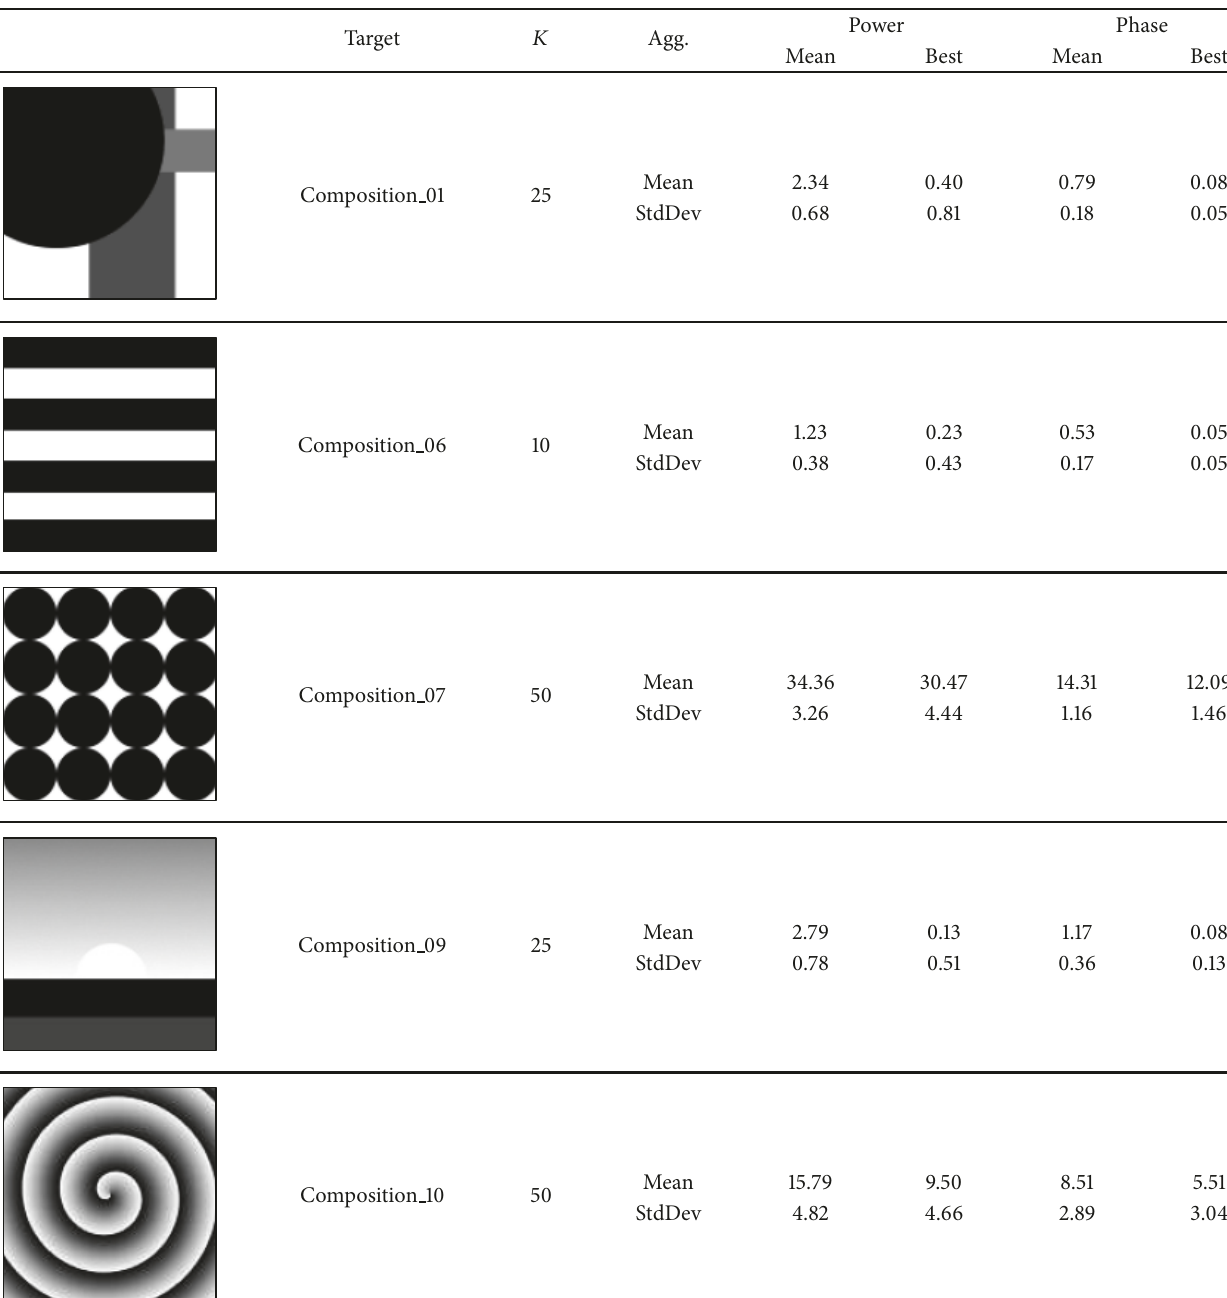
Table 4: Compositional fitness summary table. Summaries for the remainder of the section were produced over 30 runs. For each target, a row is included for the mean and standard deviation for each fitness objective aggregate. Our experiment held two objectives, aiming to minimize error in power and phase coefficient matching. The row for “mean” shows the mean of terminal populations’ average fitness and the mean of terminal populations’ best found candidates across 30 runs. Maximum and expected error values are constrained by choice of 𝐾 . Target 𝐾